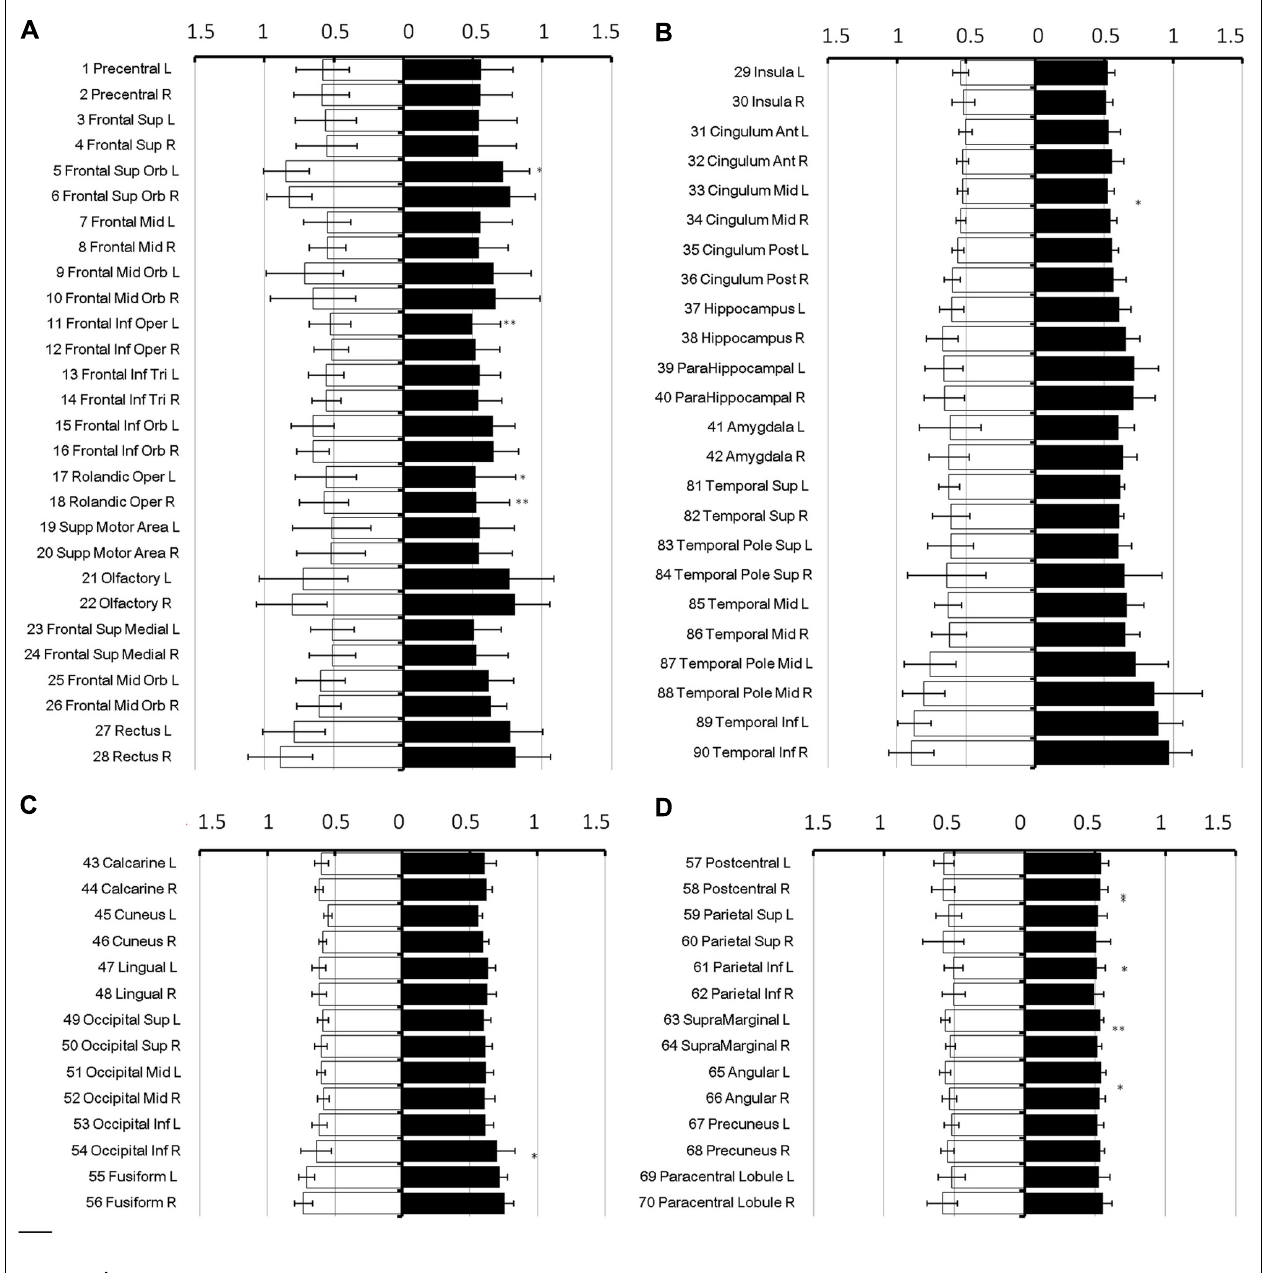
FIGURE 2 | Diffusion kurtosis in parcellated cortical regions. The diffusion kurtosis in parcellated cortical regions was plotted for male [filled] and female [blank], respectively.The AAL regions are divided into frontal (A) , temporal